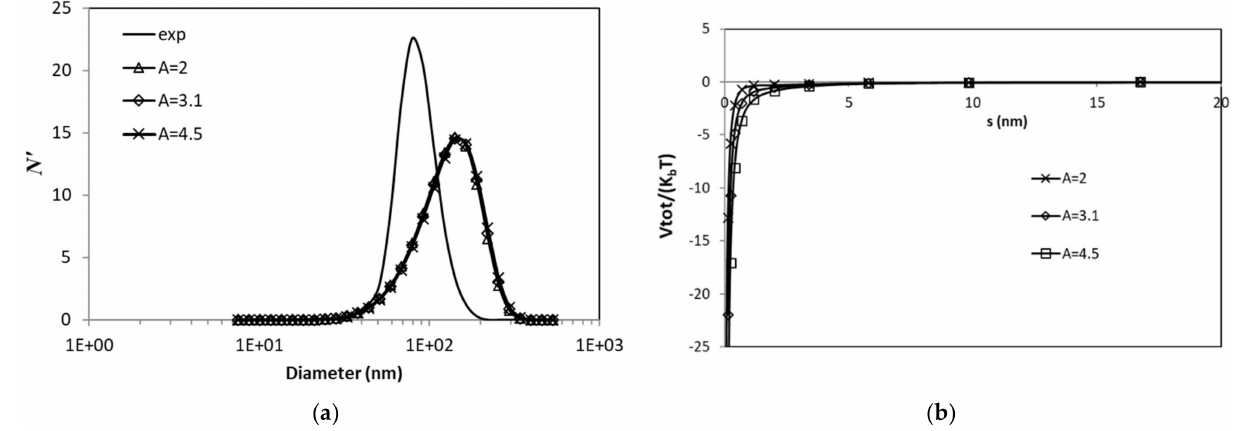
Figure 7. Effects of Hamaker constant for PBS on ( a ) particle size distribution; ( b ) total potential energy (values of A are in 10 − 20